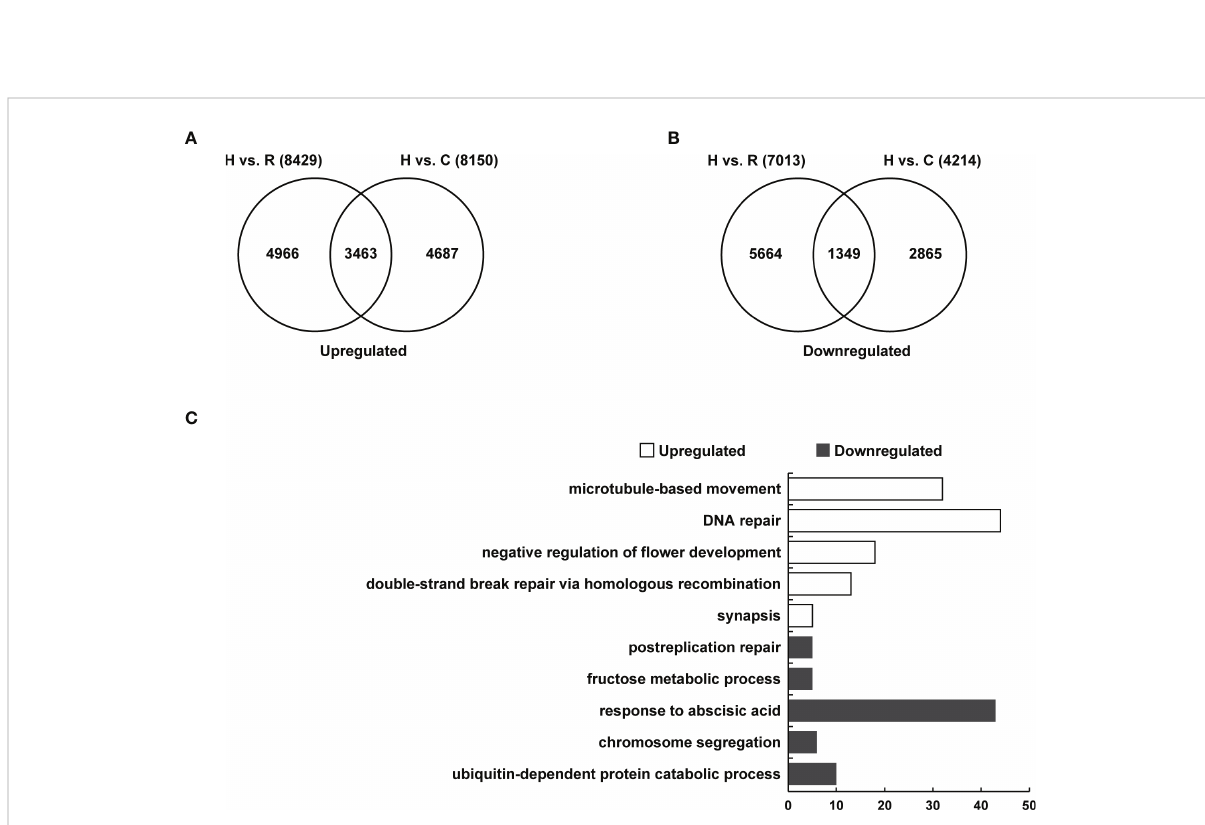
FIGURE 7 Transcriptome analysis of fl ower buds at meiosis in the Brassica allohexaploids. (A) Venn diagram showing the overlap of upregulated genes between Brassica allohexaploids vs. B. rapa and Brassica allohexaploids vs. B. carinata . (B) Venn diagram showing the overlap of downregulated genes between Brassica allohexaploids vs. B. rapa and Brassica allohexaploids vs. B. carinata . (C) GO classi fi cation of the overlapping genes upregulated and downregulated between Brassica allohexaploids vs. B. rapa and Brassica allohexaploids vs. B. carinata